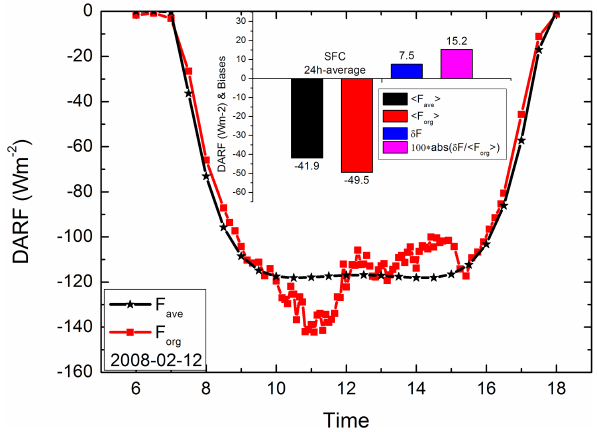
Figure 5. The same as Fig. 2 but using the AOP in Fig. 4.